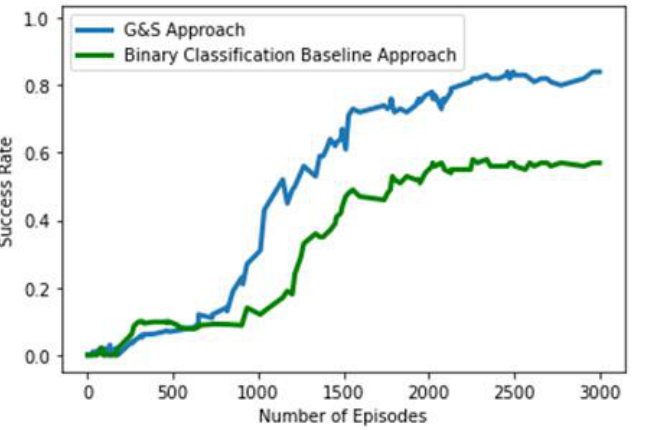
Figure 12. Performance comparison of original G&S approach and binary classification baseline approach.